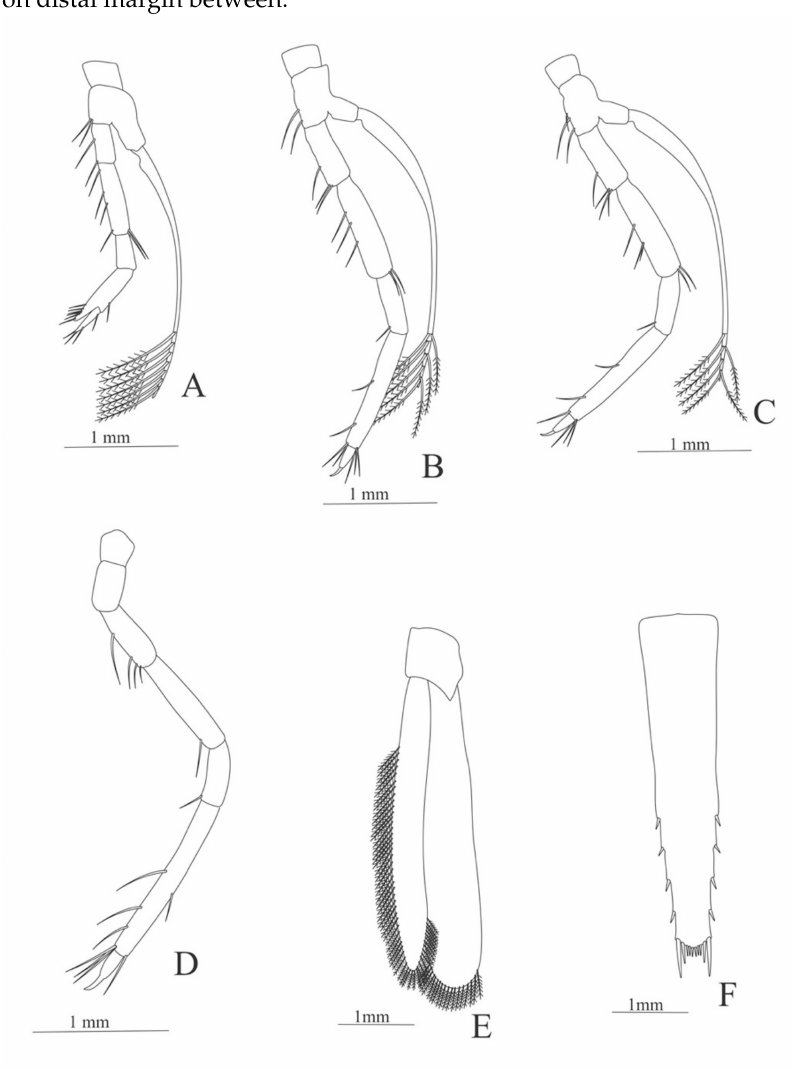
Figure 9. Alvinocaris stactophila : ( A ) second pereopod; ( B ) third pereopod; ( C ) fourth pereopod; ( D ) fifth pereopod; ( E ) uropods; ( F )